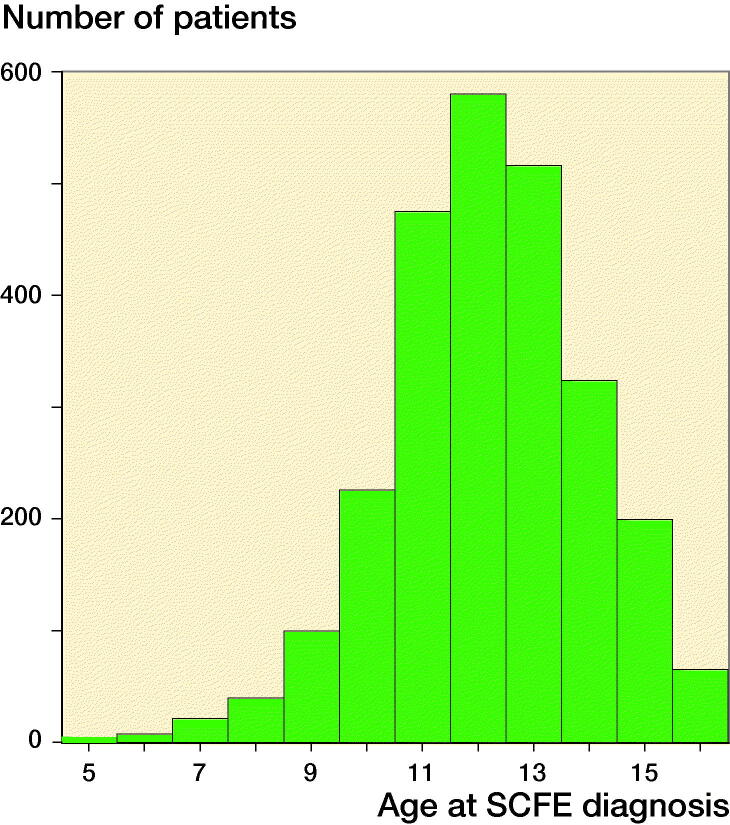
Age at onset of SCFE diagnosis with a peak between 10 and 15 years of age.